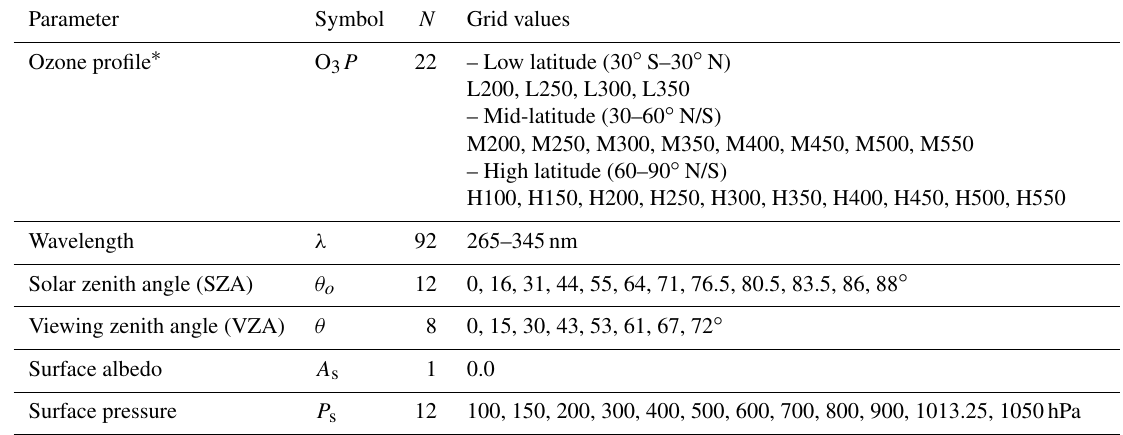
Table 2. LUT parameter specification. Note that the relative azimuth dependence is taken into account explicitly through the Fourier coeffi- cients of path radiance (Table 3), and the surface albedo dependence is taken into account by the planetary problem.